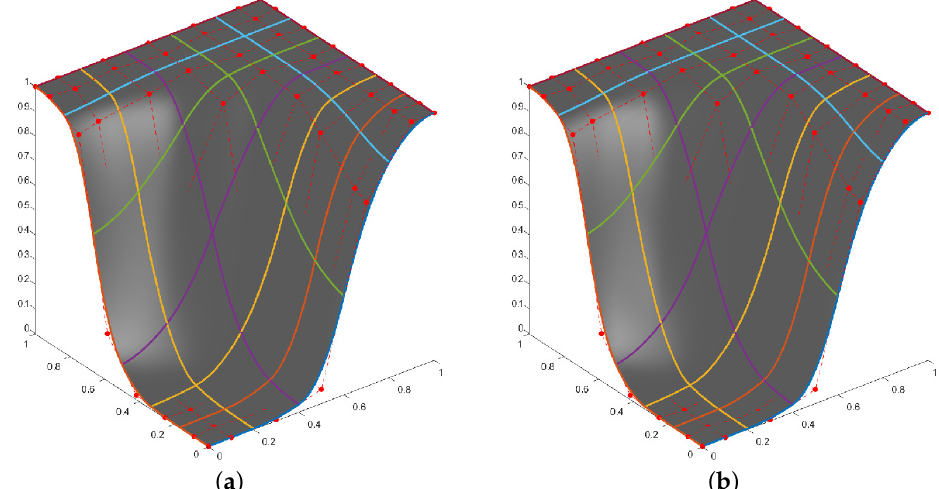
0,0,0, 1 , 2 , 3 , 4 ,1,1,1 5 5 5 5 { 10 − 2 , 2.43 10 − 3 ) , obtained · − ·